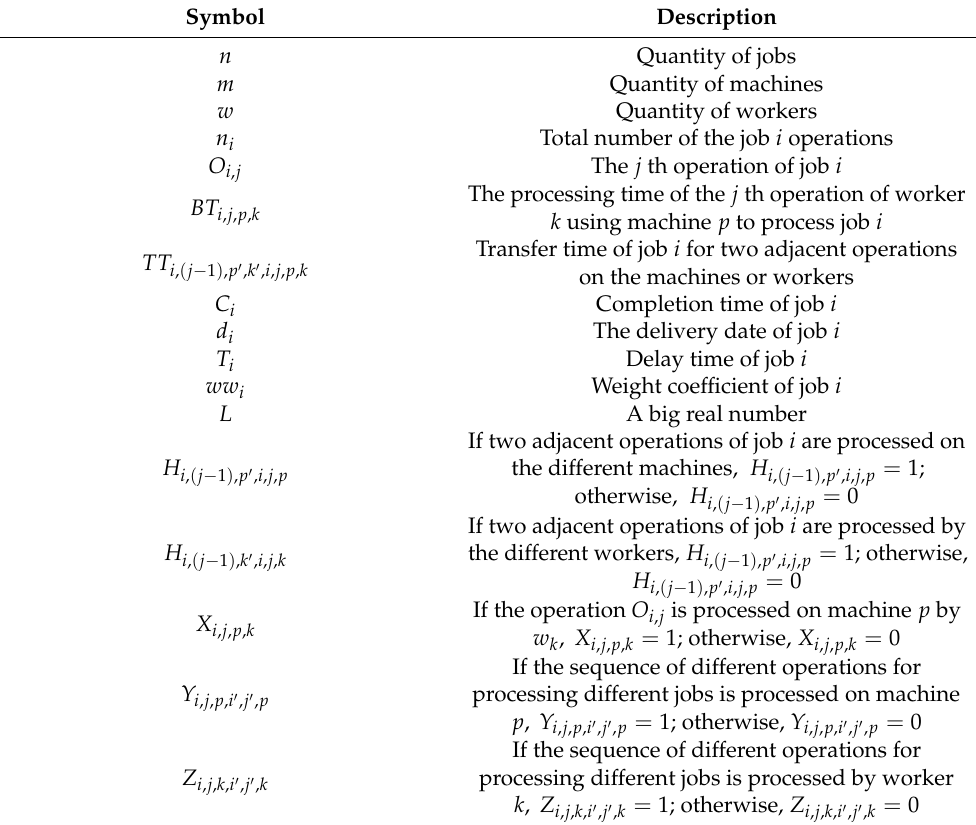
Table 1. Definitions of